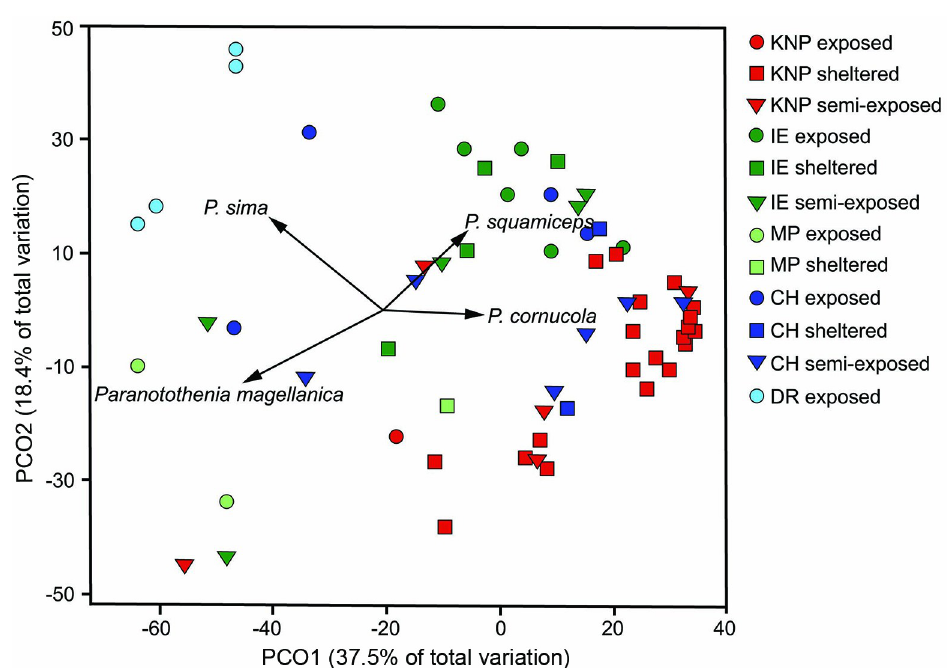
Fig 4. Principal coordinates analysis of fish assemblages based on numerical abundance by location and exposure. Data were ln(x+1)-transformed prior to analyses. Vectors are the primary taxa driving the ordination (Pearson correlations � 0.5). P . = Patagonotothen